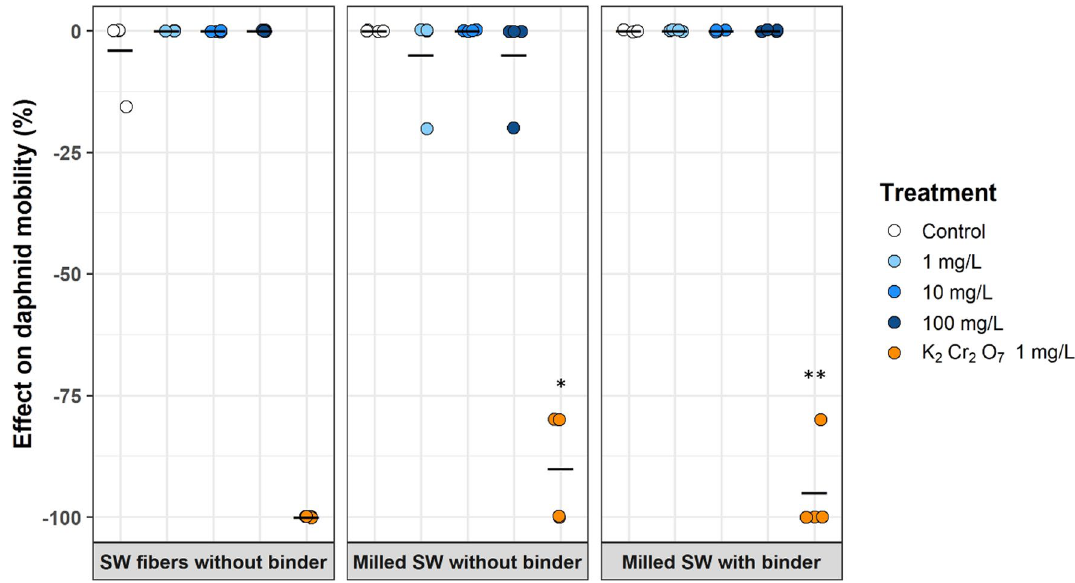
Fig. 5 Acute effects (48 h) on Daphnia mobility for the negative control (white), the eluates of three concentrations (1, 10 and 100 mg/L) of each of the three test materials (blue colors) and the positive control (potassium dichromate; orange color) as individual values and means of n (black dash). Effects were calculated in comparison to the mean value of D. magna mobility in the negative control and negative effect values show